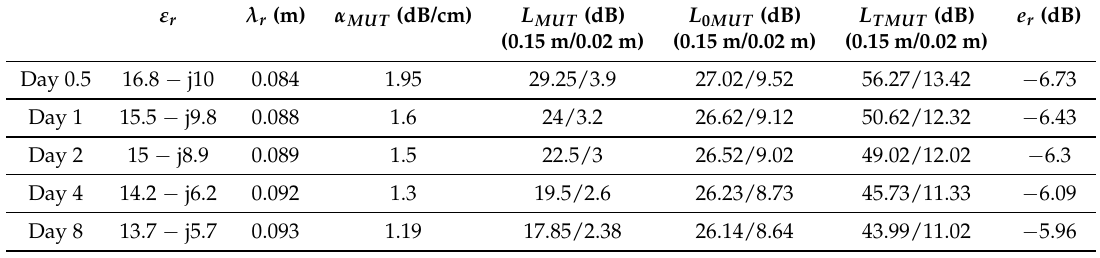
Table 3. Concrete propagation parameters for d MUT = 0.15 m and 0.02 m